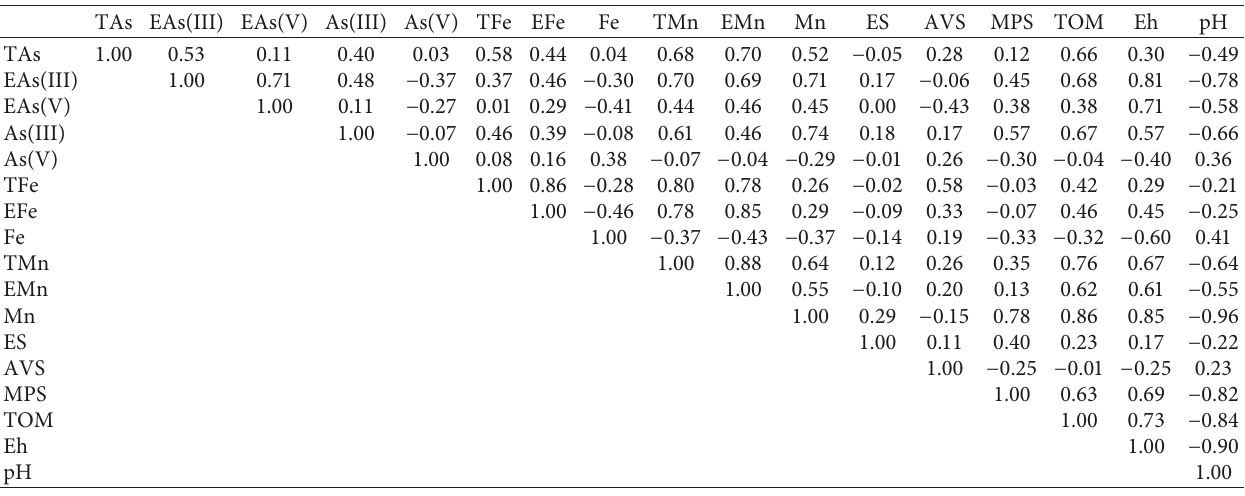
Table 1: Statistical correlations ( r ) between profiles of parameters at the intertidal